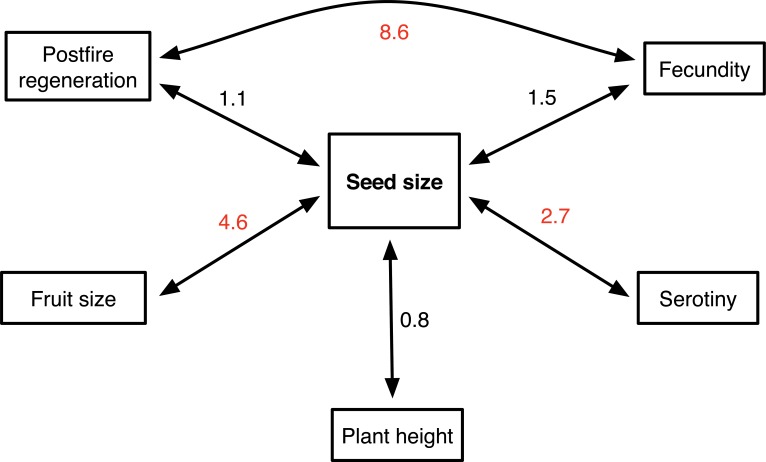
Evolutionary associations between pairwise traits in Hakea.Numbers beside the arrows are Bayes factors (BF), with BF > 2 indicating strong association.